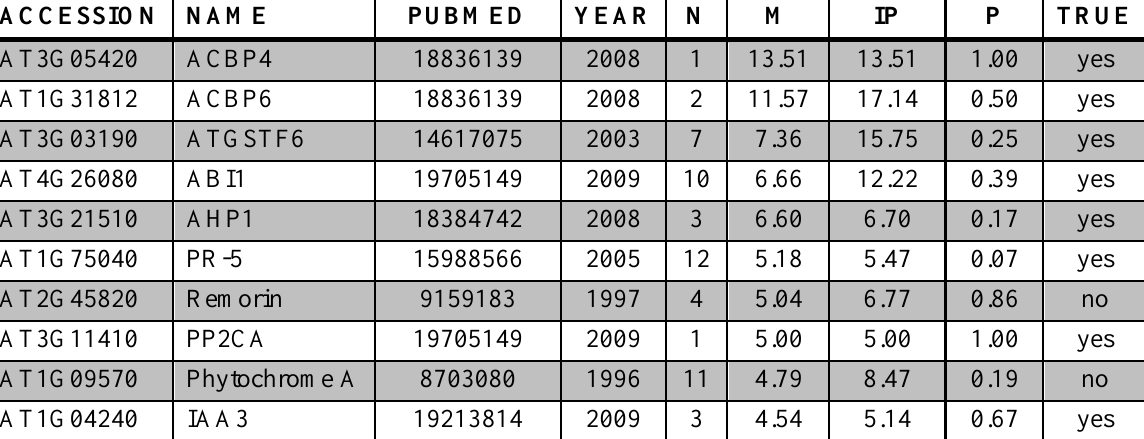
Table 1: Top 10 ethylene related proteins (sorted by M) that the text mining analysis predicted but were not found in AHD. Each row displays the top hit PubMed ID and the year of publication. The next three columns show the weights of the protein-stress association according to different scoring metrics (see Section 2.1.3). The P-value calculation is described in Section 2.2. The last column indicates whether the association is correct or not according to expert